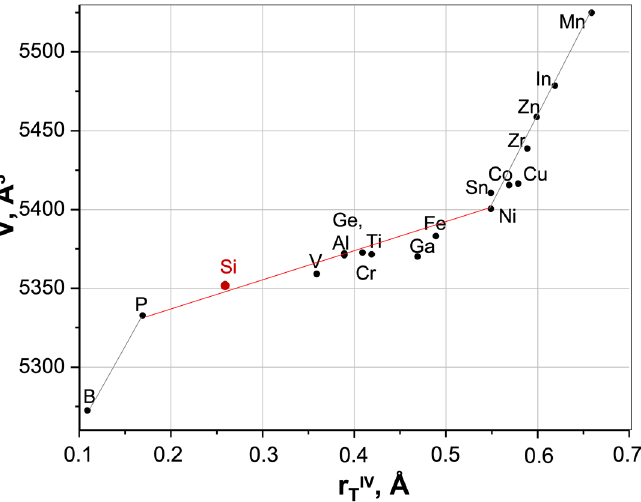
Figure 2. Relationship between the radius of T ions ( r TIV , Å) and the unit cell volume (V, Å 3 ) of (H)ZSM (Data from [98–113]).